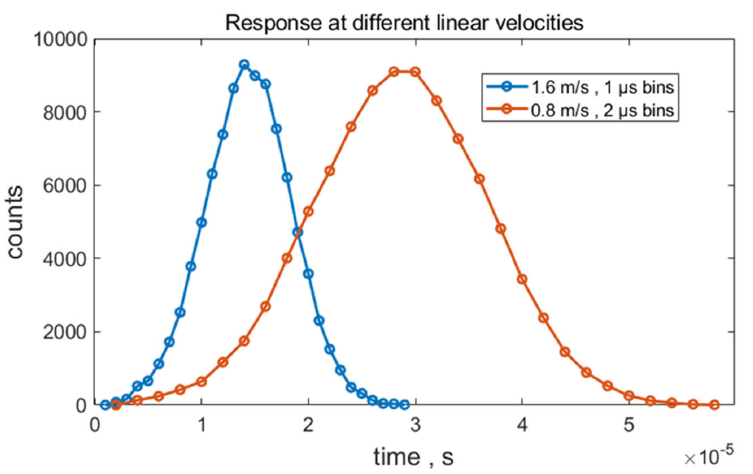
Figure 2. Model calculation of the time sequence of outputs from the analog ‐ to ‐ digital converter for a single transit of a bead through the laser beam. The pulse height is about 9100 digital units and represents one event on the histogram in Figure 1. The blue and orange dots are for beads with different linear velocities. The model automatically adjusts the time bin width to give the same pulse height at different linear flow velocities.